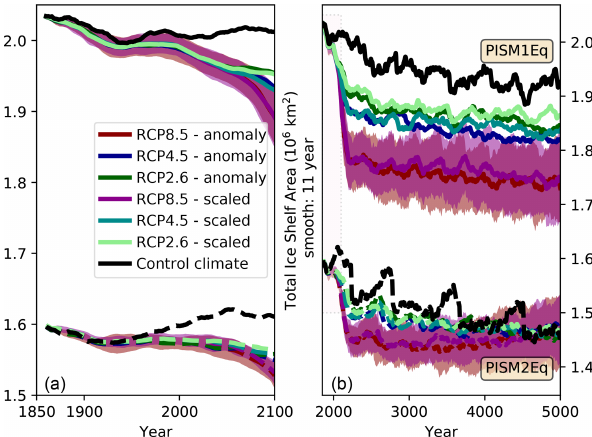
Figure E15. Area of floating ice shelves. An 11-year running mean window is used for the entire ensemble of ice sheet simulations. The solid lines represent the ensemble averages for the PISM1Eq starting conditions, and the dashed lines are the corresponding PISM2Eq condition. For the RCP8.5 scenario, the shading highlights the standard deviation (1 σ ) as a measure of the variability among the ice sheet ensemble members driven by various climate models (Table 1). Note the different axes for both panes. The dashed frame in the right panel depicts the value range of the left